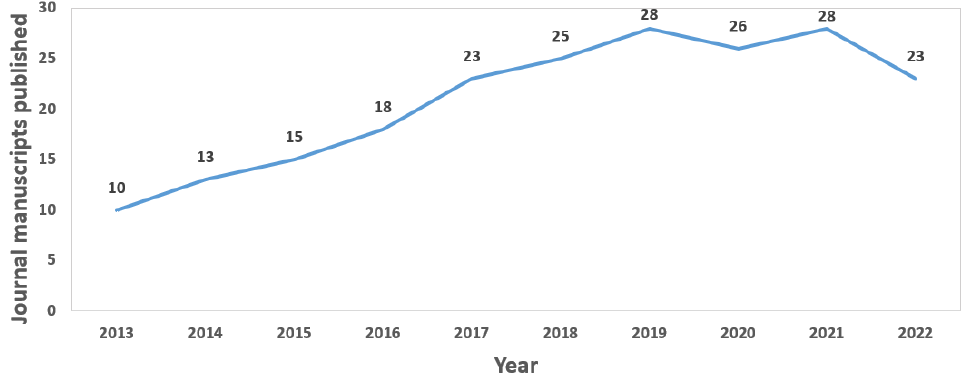
Figure 5. Evolution of journal publications.